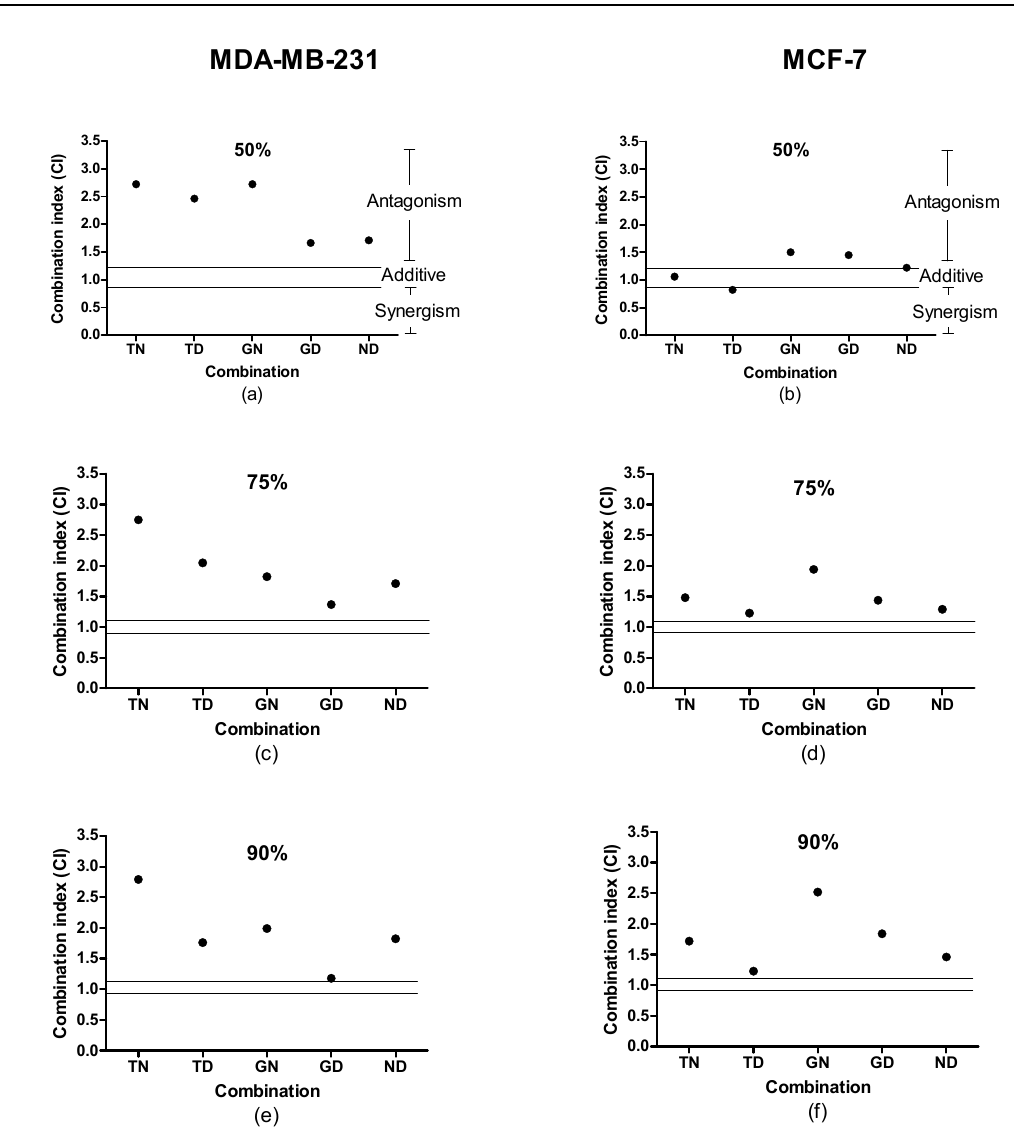
Figure 1. Combination index (CI) values were calculated for the respective two-cannabinoid combinations determined in the MDA-MB-231 ( a , c , e ) and MCF-7 ( b , d , f ) cell lines at 50% ( a , b ), 75% ( c , d ), and 90% ( e , f ). CI signifies the combination index at 50%, 75%, and 90% inhibition of the cell population, where CI = [1/Dx)1] + [2/Dx)2], where Dx = Dm[fa/(1-fa)]1/m. A CI < 1 indicates synergism, CI = 1 indicates an additive effect, and CI > 1 indicates antagonism. T, THC; G, CBG; N, CBN; D, CBD. Screening four-cannabinoid combinations (Figure 2) yielded highly cytotoxic growth inhibition percentages ranging between 94% and 100% across both cell lines.